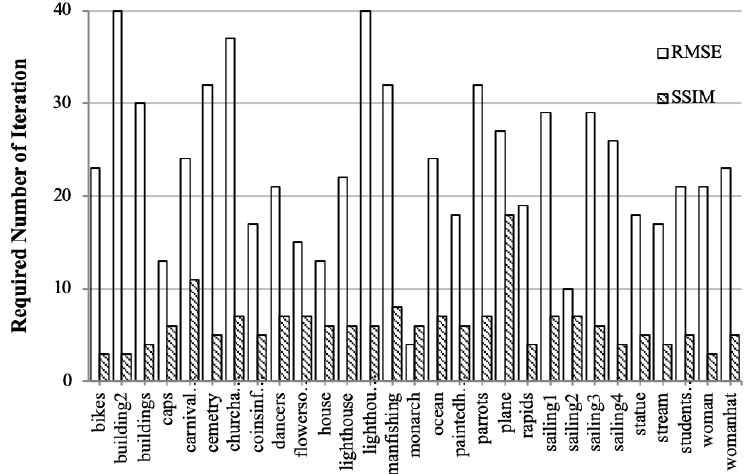
Figure 11. The required number of iterations to reach the convergence for the FiDOC algorithms based on RMSE and SSIM.